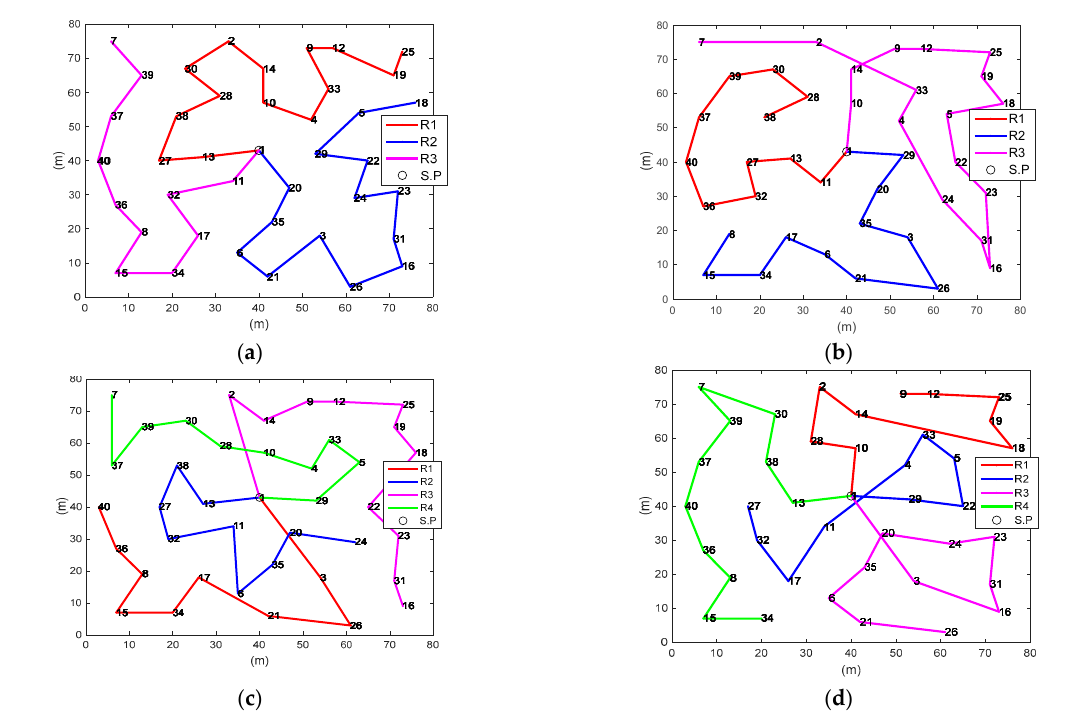
tasks m = 40, and the task nodes are represented by 1–40 serial numbers. The simulation diagram of optimal task planning and the iterative curve of robot energy consumption are shown in Figures 11 and 12.